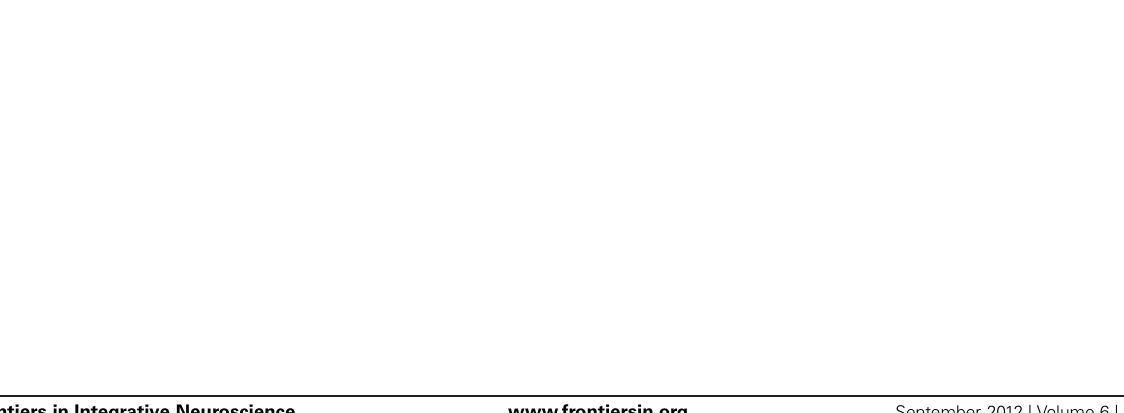
Frontiers in Integrative